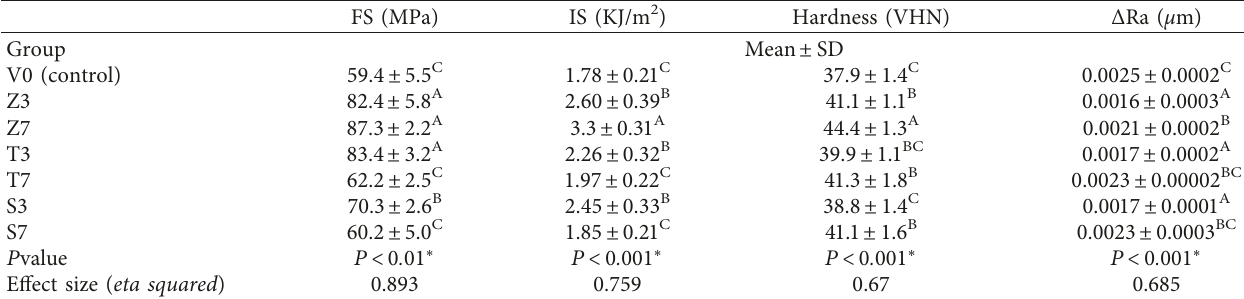
Table 4: 1-way ANOVA and pairwise comparisons tests between different acrylic resin subgroups for all tested properties.